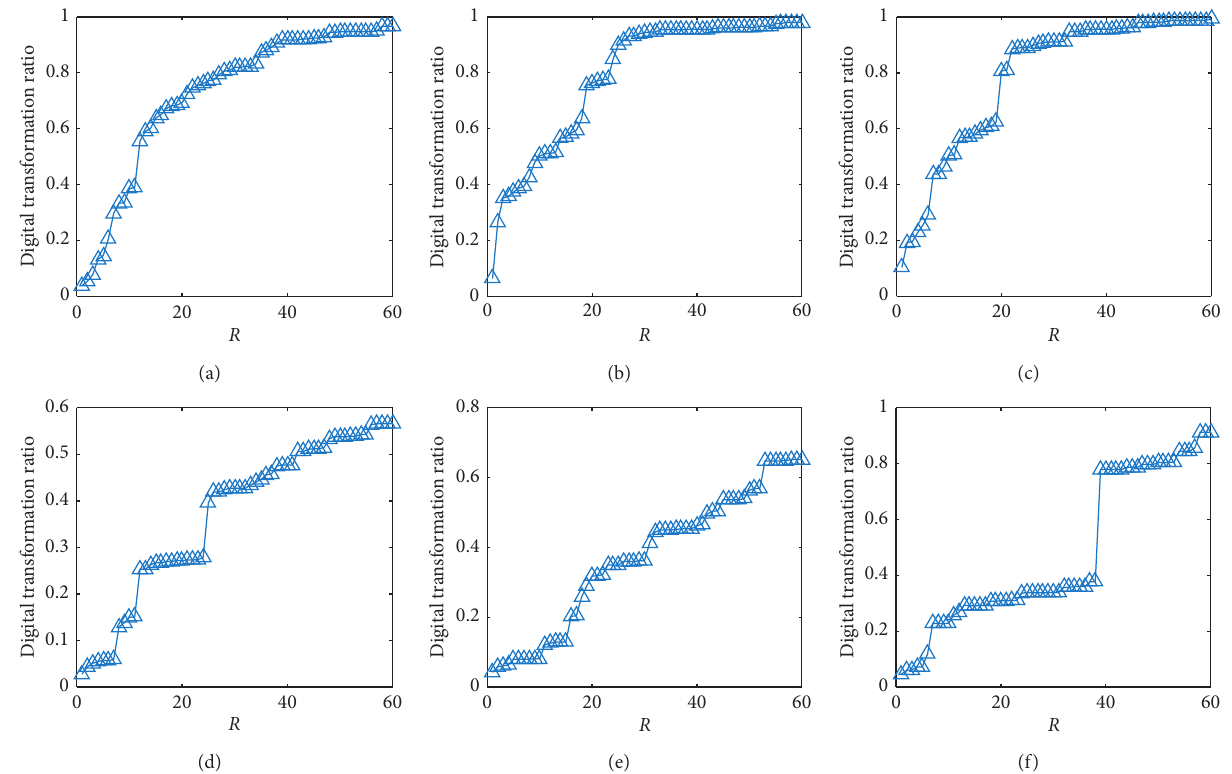
Figure 7: The proportions of enterprises carry out digital transformation under different demand-side policies: (a) p 1 � 0.3, Cu � 1, Cb � 2; (b) p 1 � 0.5, Cu � 1, Cb � 2; (c) p 1 � 0.7, Cu � 1, Cb � 2; (d) p 1 � 0.3, Cu � 2, Cb � 4; (e) p 1 � 0.5, Cu � 2, Cb � 4; (f) p 1 � 0.7, Cu � 2, Cb � 4.